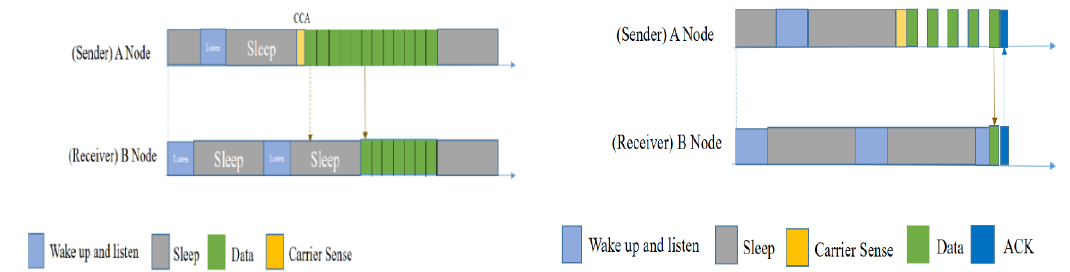
Figure 8. Packet transmission in BoX-MAC-1 ( left ) and BoX-MAC-2 ( right ) [31].